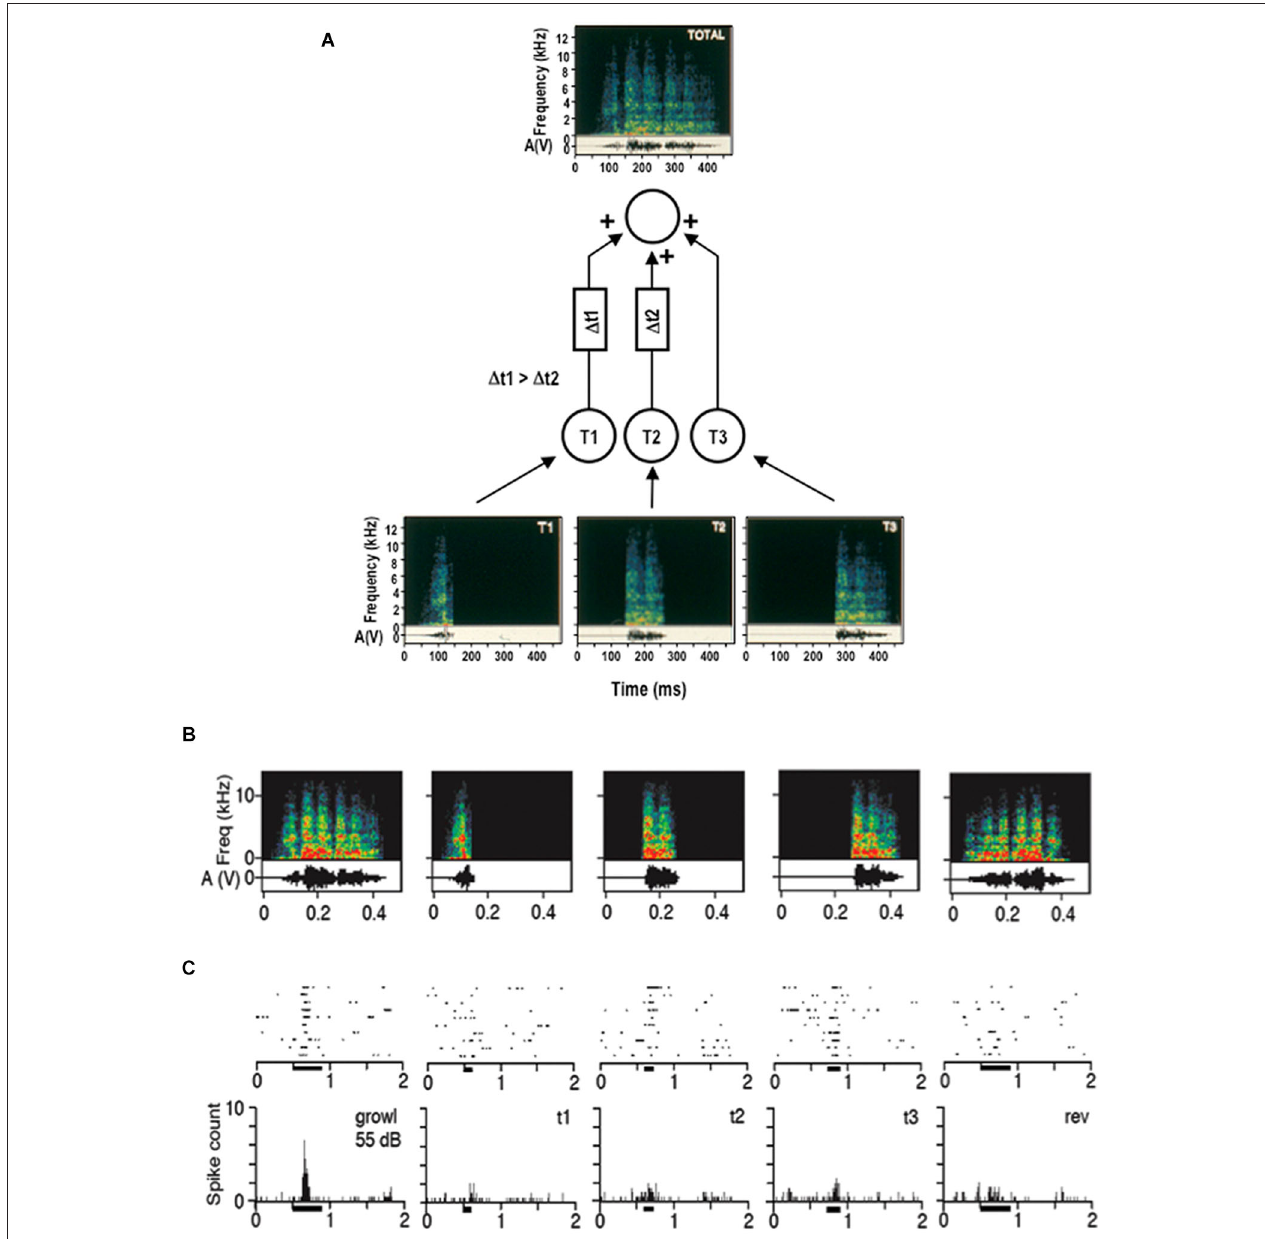
FIGURE 1 | Auditory direction selectivity of a cortical neuron as cellular basis for sequence selectivity. (A) Schematic drawing of a neuron in the lateral belt of rhesus monkey auditory cortex, illustrating temporal combination sensitivity (TCS). Input from lower-order neurons is integrated at the level of the lateral belt in a nonlinear fashion (Rauschecker et al., 1995). The belt neuron acts as a logical AND-gate and fires only if the membrane potential surpasses a given